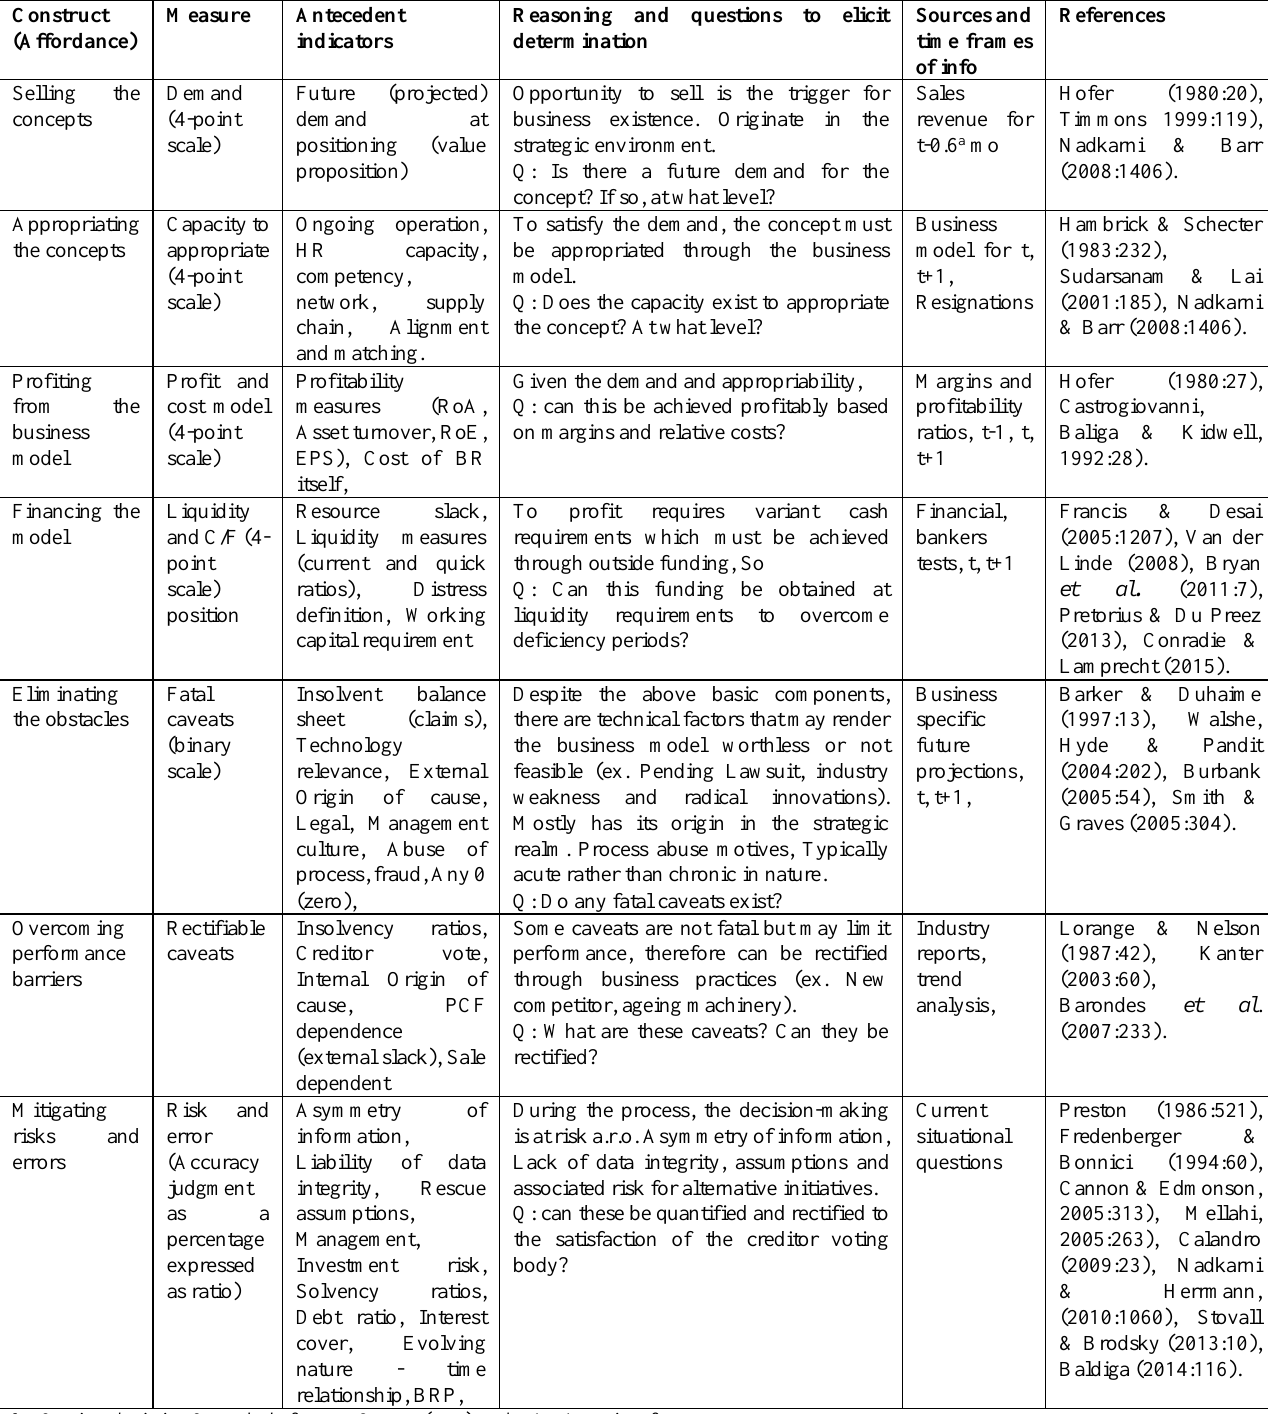
Table II: Criteria for evaluation when determining reasonable prospect commencement standard of a business operating in the zone of